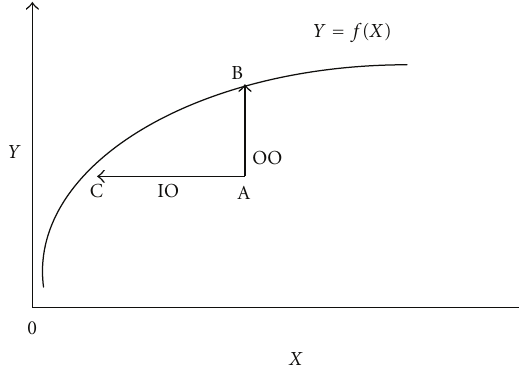
Figure 1: IO and OO technical ine ffi